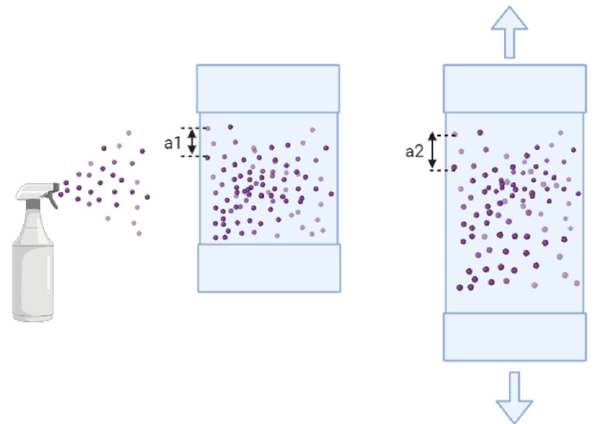
Figure 3. Schematic of preparation of PDMS chamber for DIC analysis. The dye is sprayed on the surface of the PDMS chamber. The displacement of selected dye dots was measured before and after the mechanical stretching.